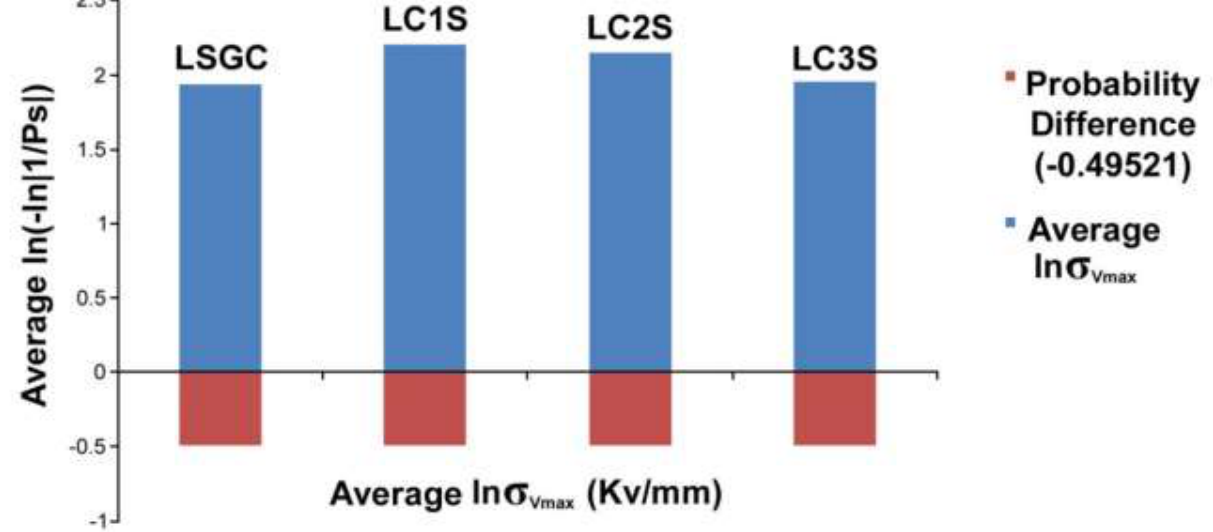
Figure 5: The probability difference value for all